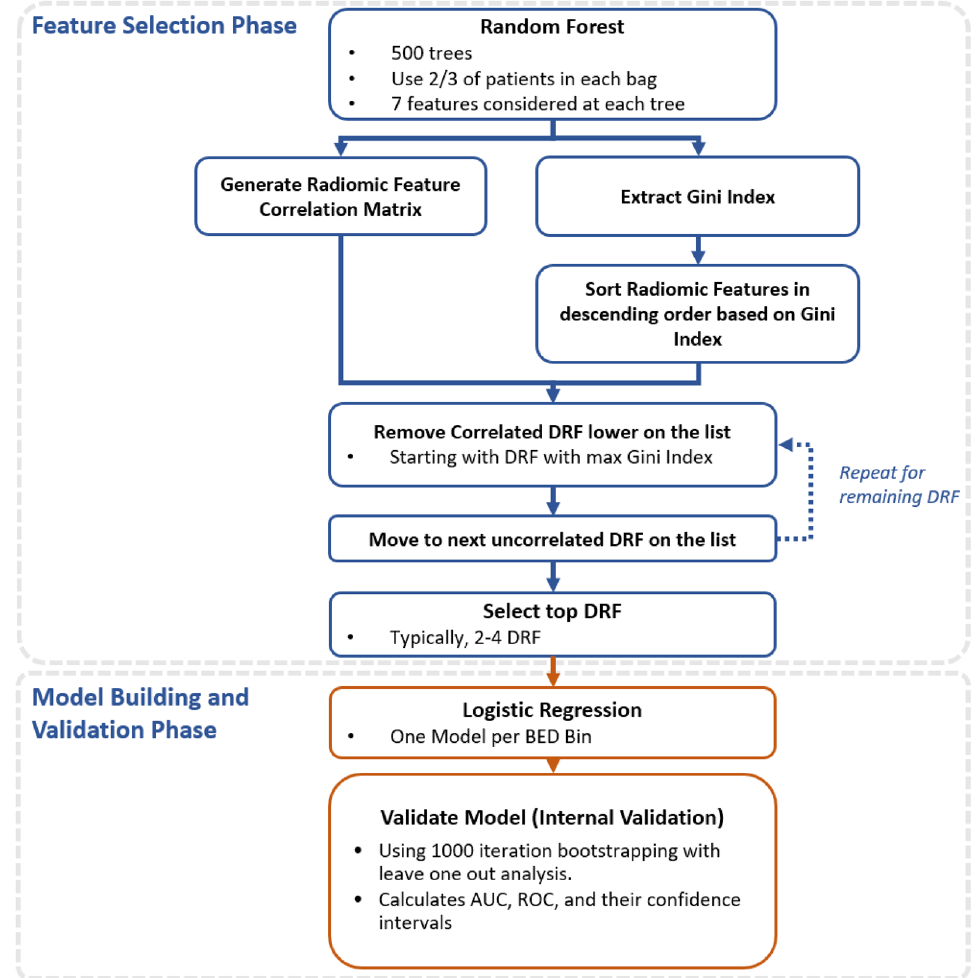
Figure 3. DRF model and analysis